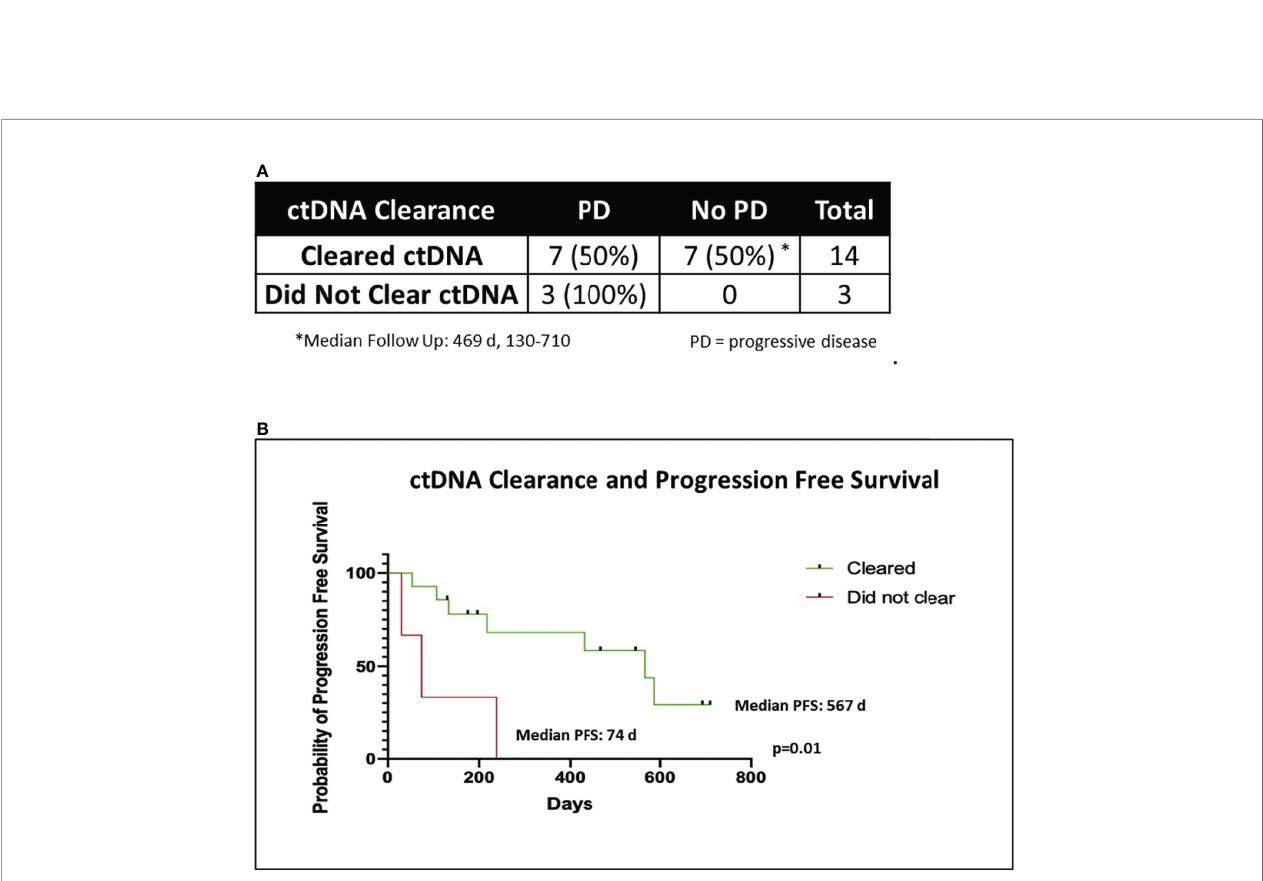
FIGURE 4 | ctDNA clearance and freedom from progression. (A) Chi-Square table of ctDNA clearance and disease progression (PD). Two of 19 patients died of non-cancer related causes before post-CRT2 and were excluded from analysis of disease progression, leaving 17 patients. (B) Kaplan-Meier graph of progression free survival (PFS) in patients who cleared ctDNA (n = 14) versus those who did not (n = 3), using the Mantel Cox log rank